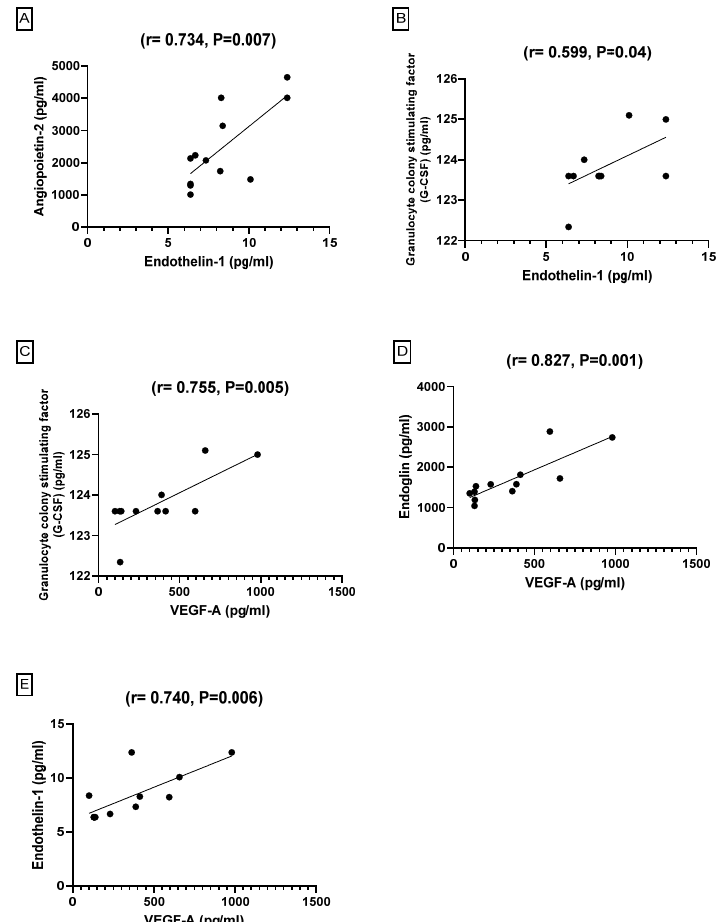
The correlation coefficient was made using the Pearson test. Middle cerebral artery occlusion (MCAO), Granulocyte colony-stimulating factor (G-CSF), Vascular endothelial growth factor-A (VEGF-A). ** Correlation is significant at the 0.01 level (2-tailed). * Correlation is significant at the 0.05 level (2-tailed).